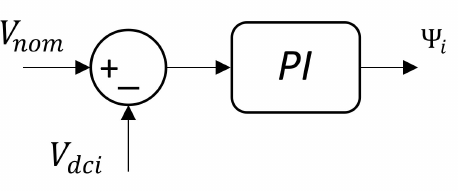
Figure 8. Distributed secondary control diagram for voltage